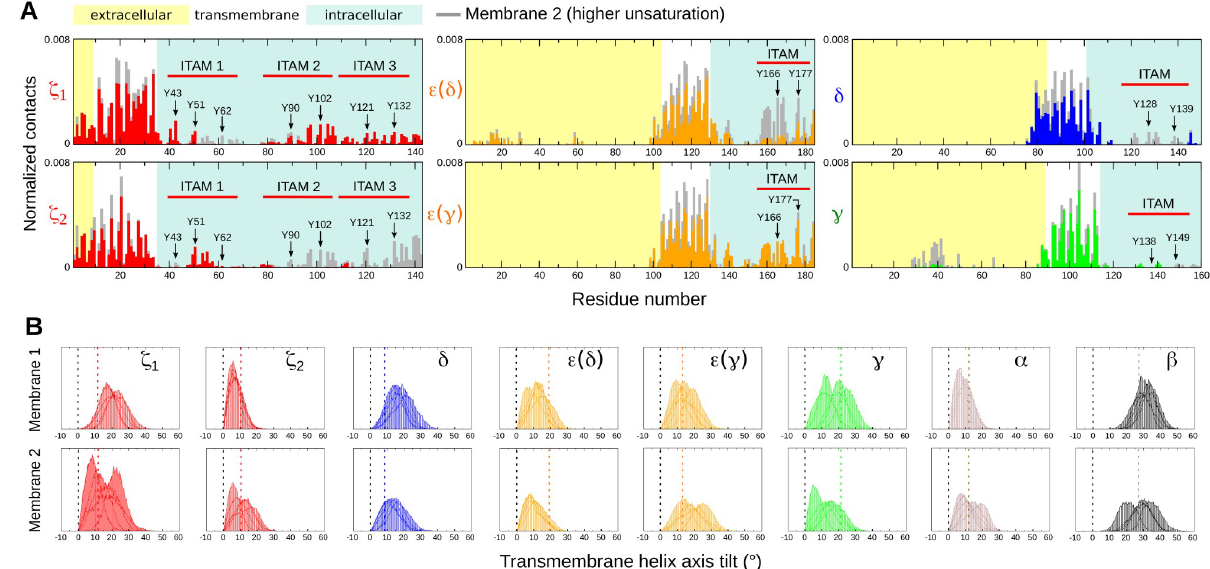
Fig 3. Interactions of ITAM tyrosines with the hydrophobic region of the membrane. (A) Normalized number of contacts of z and CD3 subunits with lipid acyl chains in membrane 1 (coloured by subunit) and membrane 2 (grey). The position of the ITAM tyrosines is indicated by arrows. For the normalization, the number of contacts of each residue was divided by the number of lipids in the membrane and the number of simulation frames. (B) Transmembrane helix tilt angle distribution of each subunit calculated from all simulations from membrane 1 (top row) and membrane 2 (bottom row). The black dotted lines represent zero tilt angle and the coloured dotted lines represent the initial tilt angles of the transmembrane helices of each subunit.